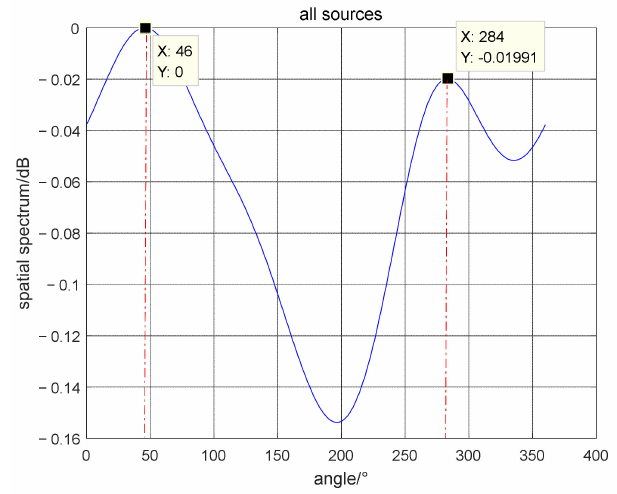
Figure 9. The azimuth of all sound